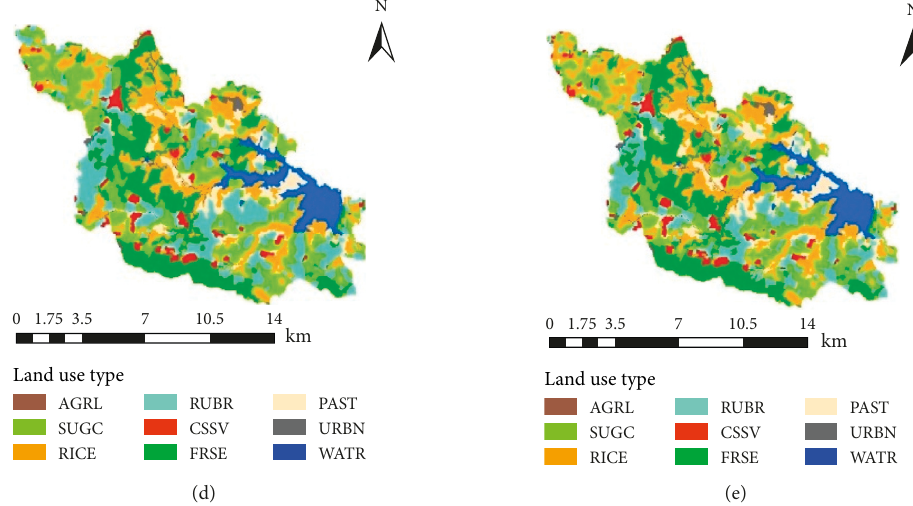
Figure 14: Simulated land use maps for 2018–2067 of the Huay Ling Jone by participation process. (a) Year 2024. (b) Year 2038. (c) Year 2052. (d) Year 2066. (e) Year 2067.